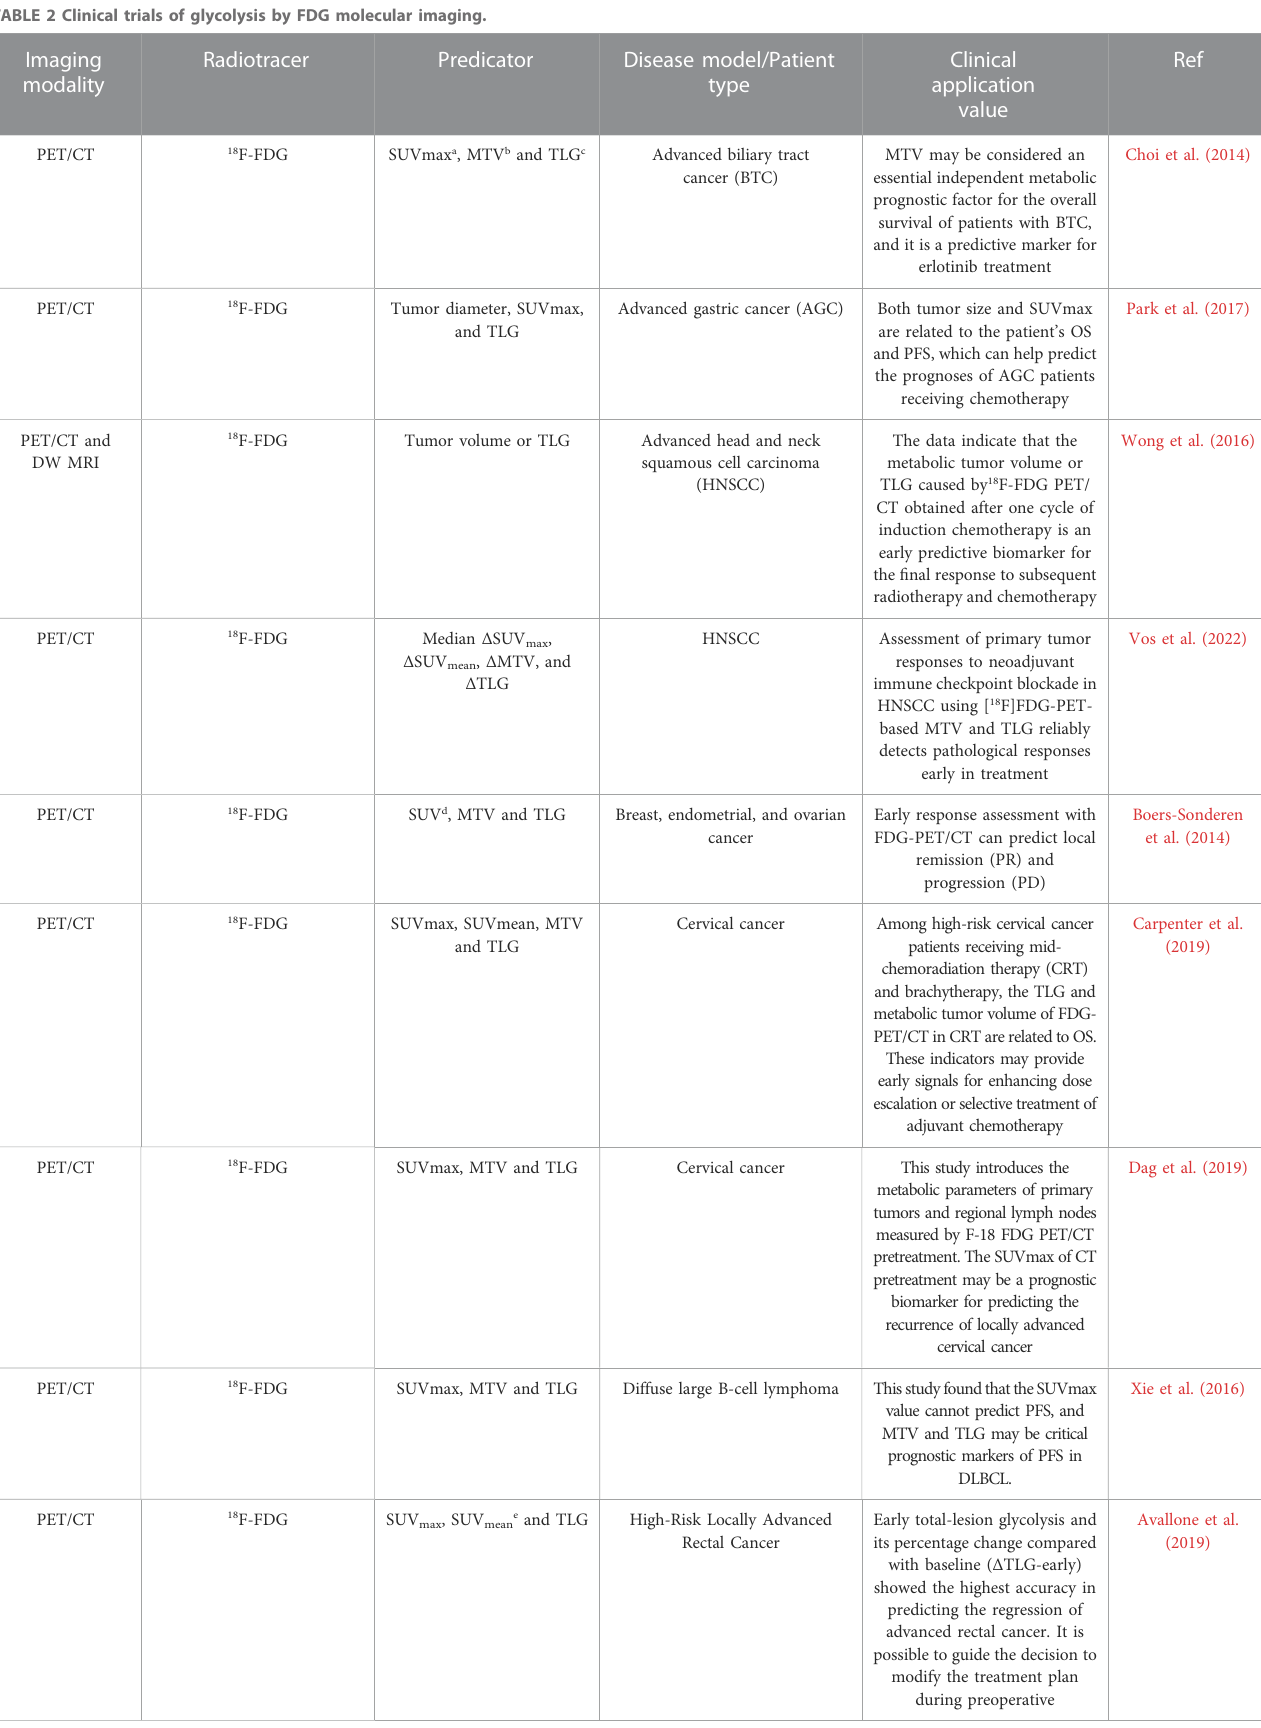
TABLE 2 Clinical trials of glycolysis by FDG molecular